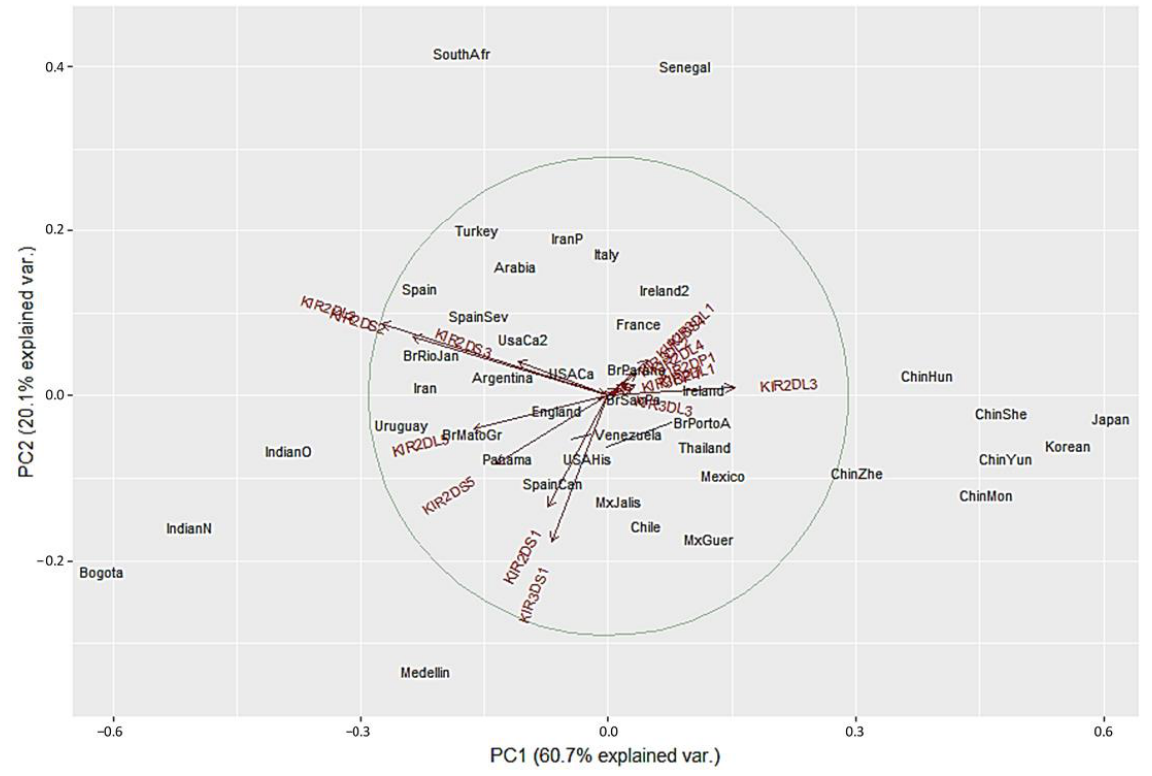
Figure 5. Principal component analysis for worldwide populations. The circle indicates the correlation between KIR gene frequencies. Red arrows show the relative contribution of each KIR gene frequency to the variability along the first two axes (PC1 and PC2). PC1 was strongly correlated with KIR2DL3 and KIR2DL2 genes and PC2 was strongly correlated with KIR3DS1 gene.